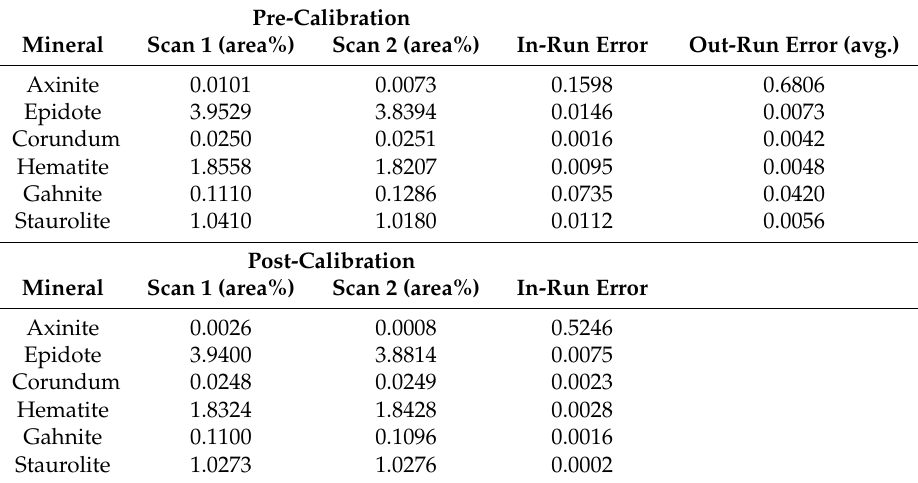
Table 2. Calculated error between two identical MLA sample runs, before and after routine gun alignment calibration, for two size fractions of polished HMC grain mount. Out-run error is calculated using all runs, regardless of pre- or